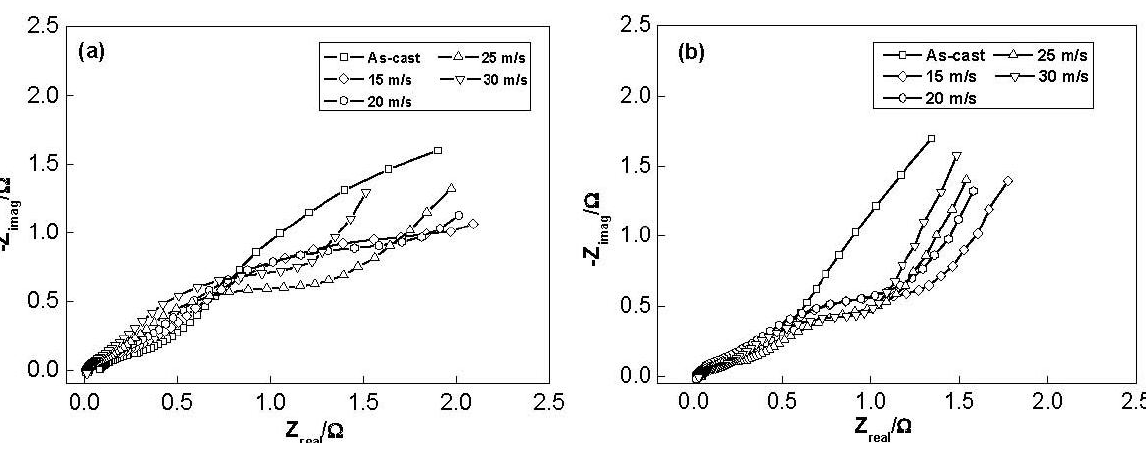
Figure 11. Electrochemical impedance spectra (EIS) of the alloy electrodes at the 50% depth of discharge (DOD): ( a ) Co